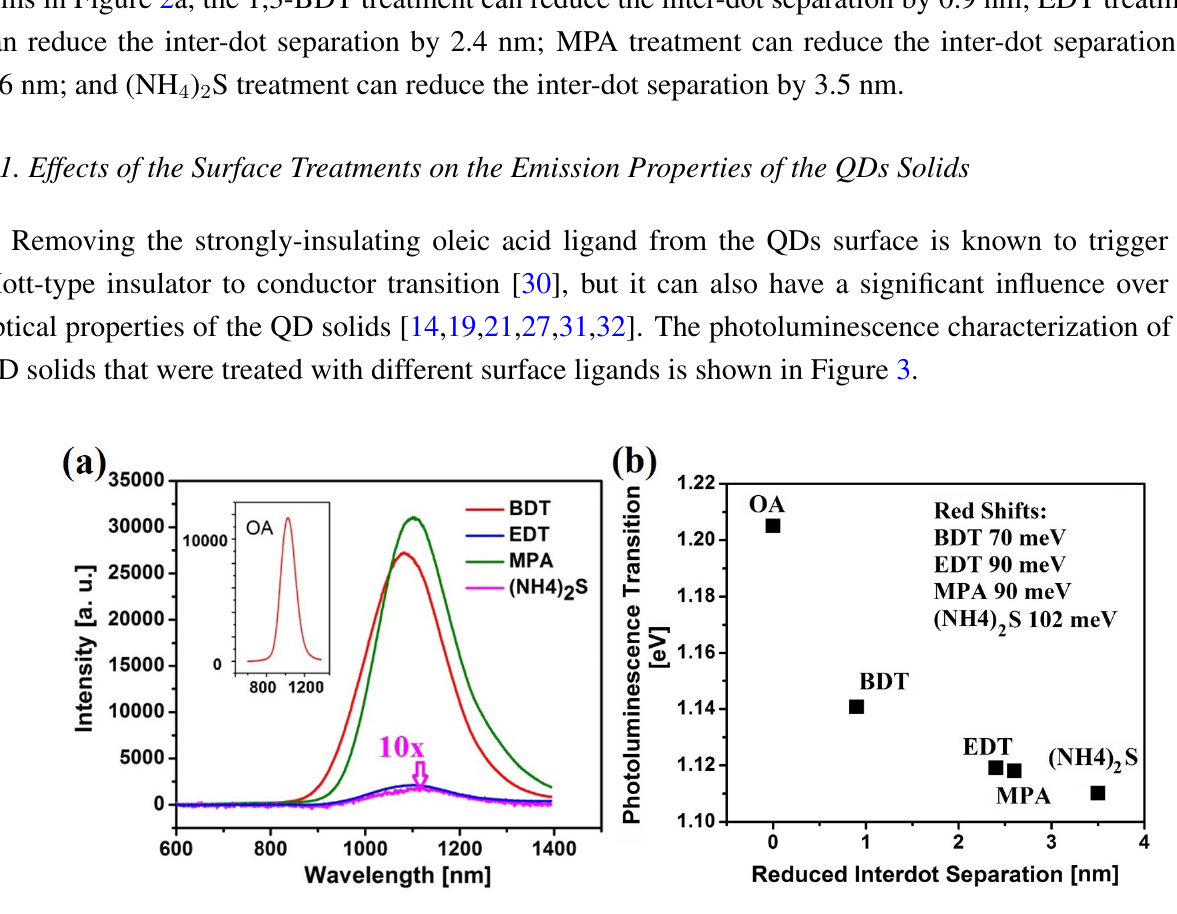
( a ) The photoluminescence (PL) spectrum of one layer of spin-coated PbS QD films treated with different surface ligands. The inset shows the PL spectrum of the original oleic acid (OA)-capped QD films for reference only. ( b ) The photoluminescence peak transition versus the reduced inter-dot separations induced by different surface ligand